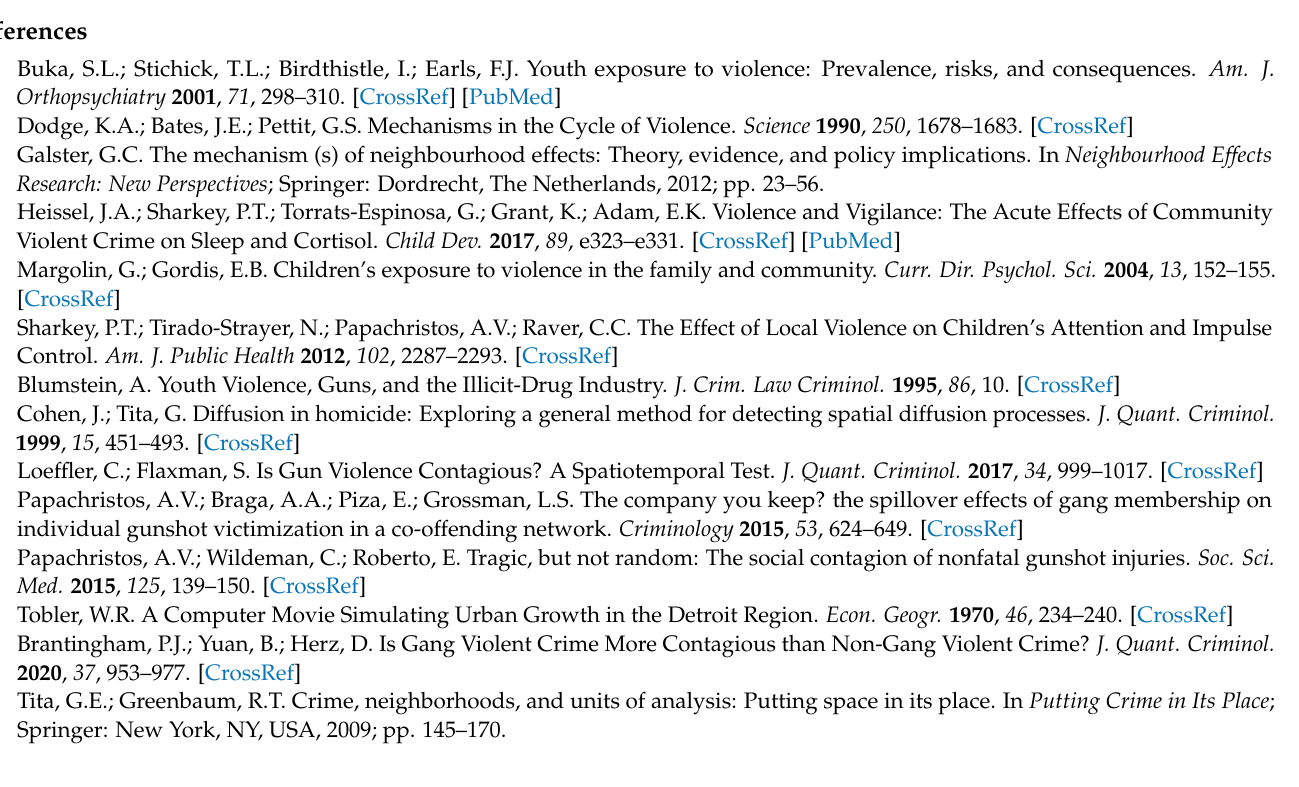
Figure S3. Queens, Figure S4. Bronx, Figure S5. Staten Island, Figure S6. Los